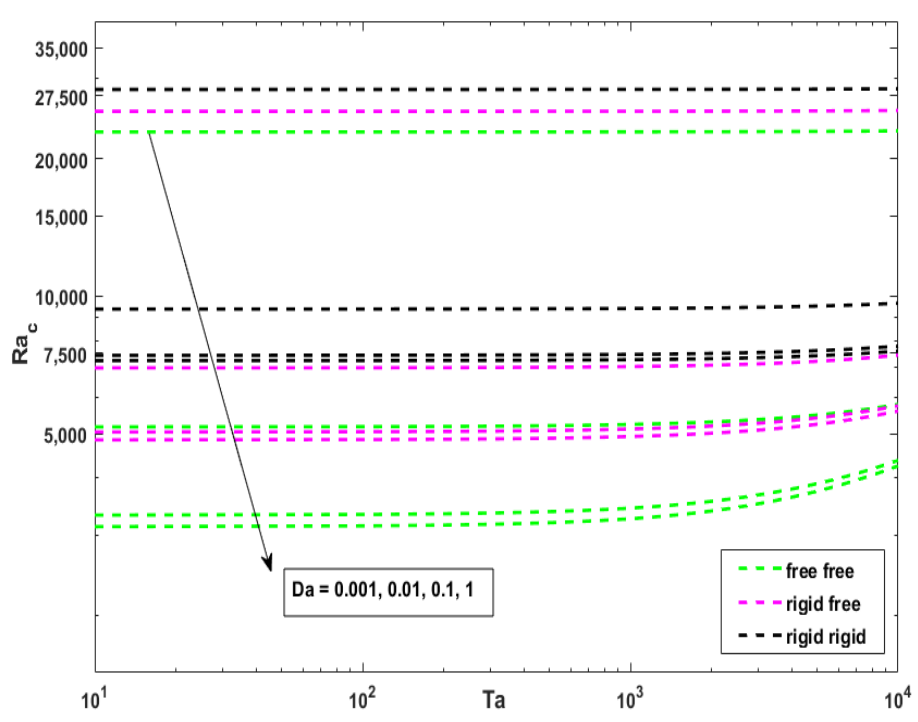
Figure 10. Variation of Ra c with Ta for Sr = 0.2, Du = 0.02, Rs = 200, Le = 5, Λ = 8, M = 0.9 , ϕ = 0.9.